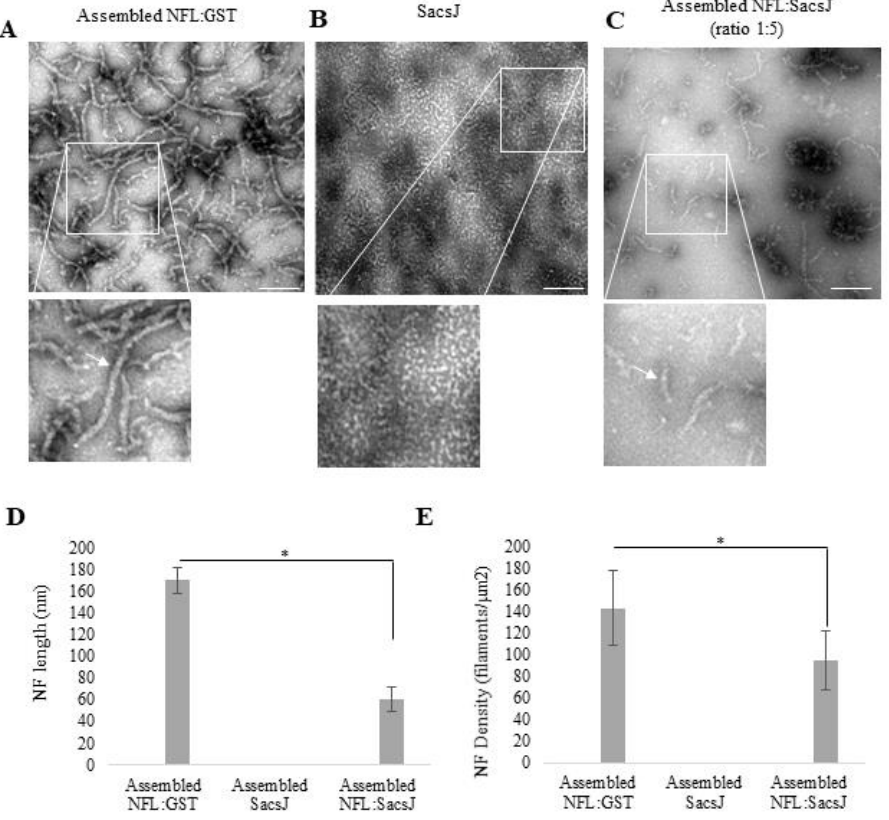
Figure 1. SacsJ disassembled NFL filaments in vitro. Shown are representative TEM images of filaments assembled from purified NFL ( A ). Assembled NFL filaments were incubated with or without SacsJ for 1 h at 37 ◦ C and observed by TEM. Representative TEM images of filamentous NFL ( A ), SacsJ alone ( B ) or filamentous NFL co-incubated with SacsJ at a molar ratio of 1:5 ( C ). Inserts show enlargements of TEM images focused on NFL filaments (arrow). Scale Bar: 40 nm. Quantitation of NFL average length ( D ) and filament density ( E ) with or without incubation with SacsJ shows the significant decrease in NFL length and density (filaments/ µ m 2 ). * p < 0.05 vs. NFL alone; one-way ANOVA, HSD Tuckey post hoc analysis ( n =